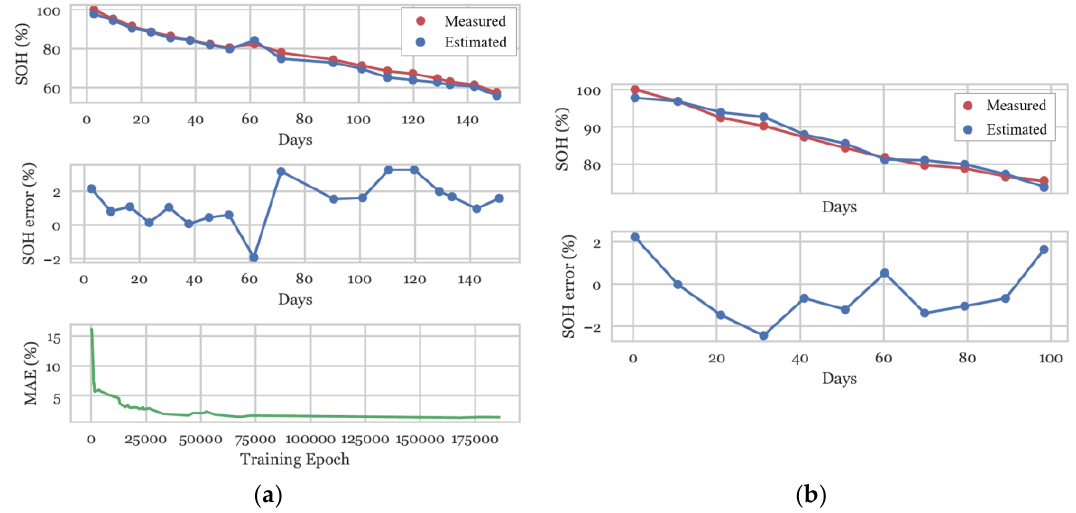
Figure 4. ( a ) From top to bottom, CNN estimation accuracy, estimation error over the 25 °C validation dataset and the mean absolute error as a function of training epochs. ( b ) Estimation accuracy and estimation error over 40 °C validation dataset. Table 2. SOH estimation accuracy of CNN for 25 ◦ C and 40 ◦ C RW aging datasets. Validation Dataset MAE (%) Validation RW dataset (25 ◦